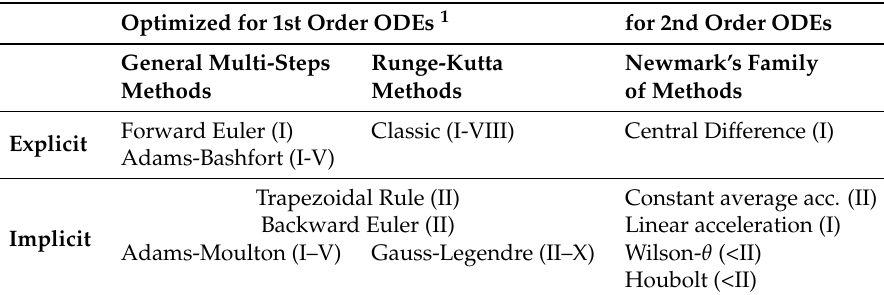
Table A1. Classification of main DTI